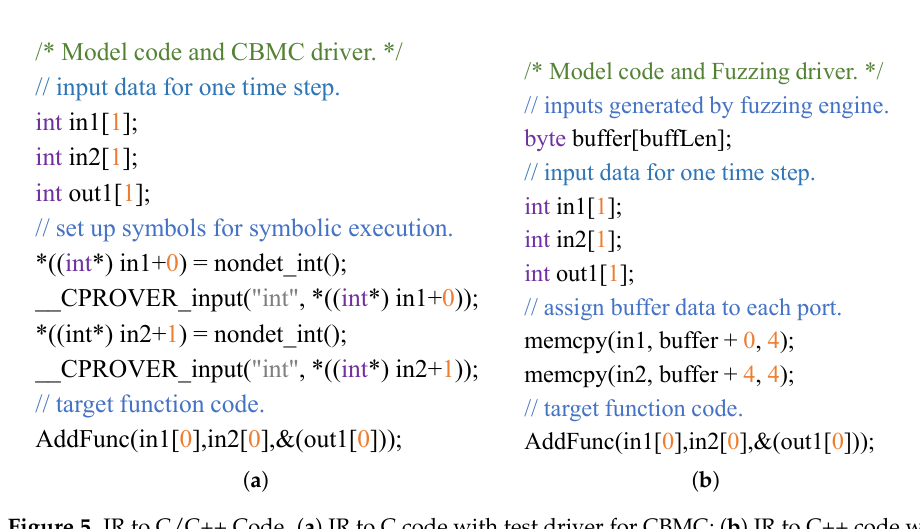
Figure 5. IR to C/C++ Code. ( a ) IR to C code with test driver for CBMC; ( b ) IR to C++ code with test driver for